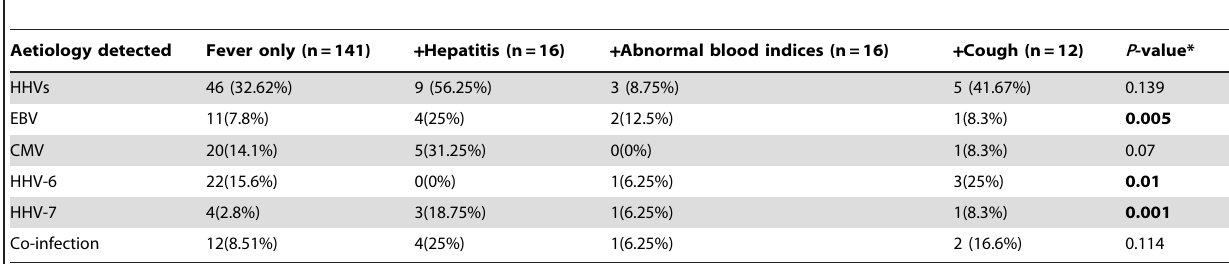
Table 3. Association of clinical signs in the FUO patients (n=184) with the viruses detected.